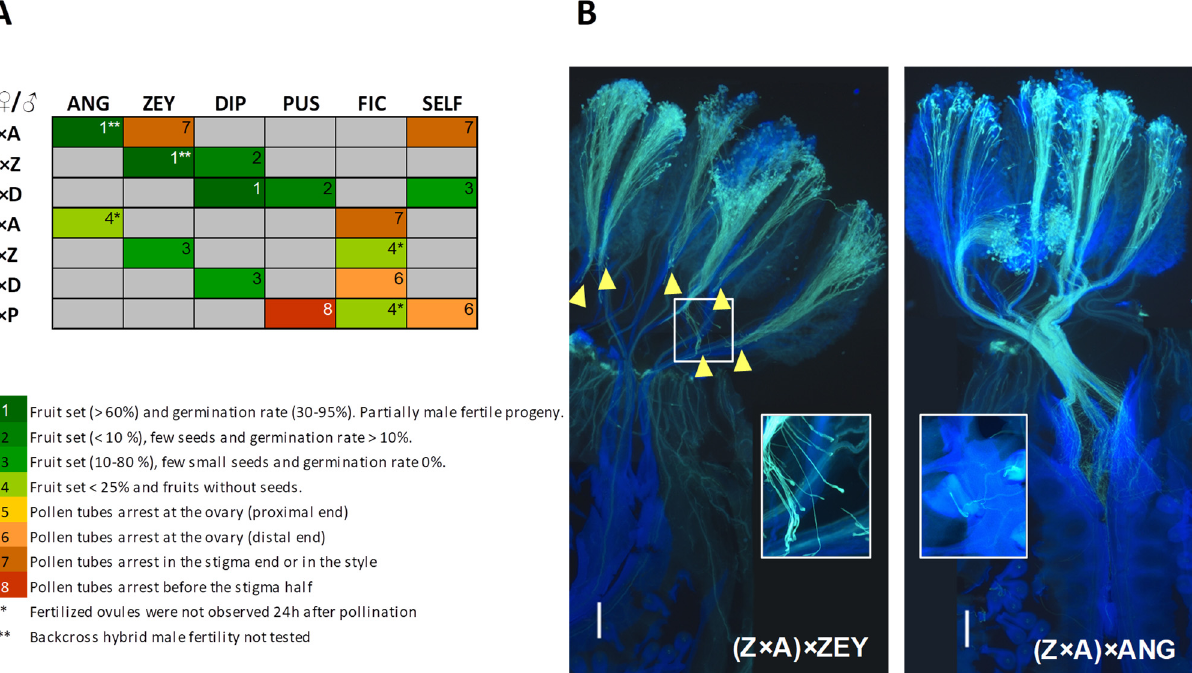
Figure 7. Backcrossing success of Cucumis interspecific hybrids. ( A ) Crossability index (CI) is indicated by numbers (1–8) and color grading (green to red) and ranges from crosses showing no IRB (level 1) to crosses impeded early after pollination (level 8). CI is determined by post-zygotic IRB that condition fruit set success, seeds viability and hybrid fertility (1–4) and pre-zygotic IRB that result in pollen tube arrest at different pistil levels (5–8). SELF column shows results of self-pollinations, when possible, and grey cells indicate not performed crosses. Fertilized ovules were observed 24 h after- pollination in all crosses with CI 1–4 (green color grade) except for those labeled with *. ( B ) Pollen tube growth in backcrosses between the hybrid Z × A and their two parents: (Z × A) × ANG and (Z × A) × ZEY. Insets show details of distorted and swollen pollen tubes in (Z × A) × ZEY and fertilized ovules in (Z × A) × ANG backcrosses, respectively. Yellow arrowheads indicate sites of pollen tube arrest. Scale bars correspond to 500 µ